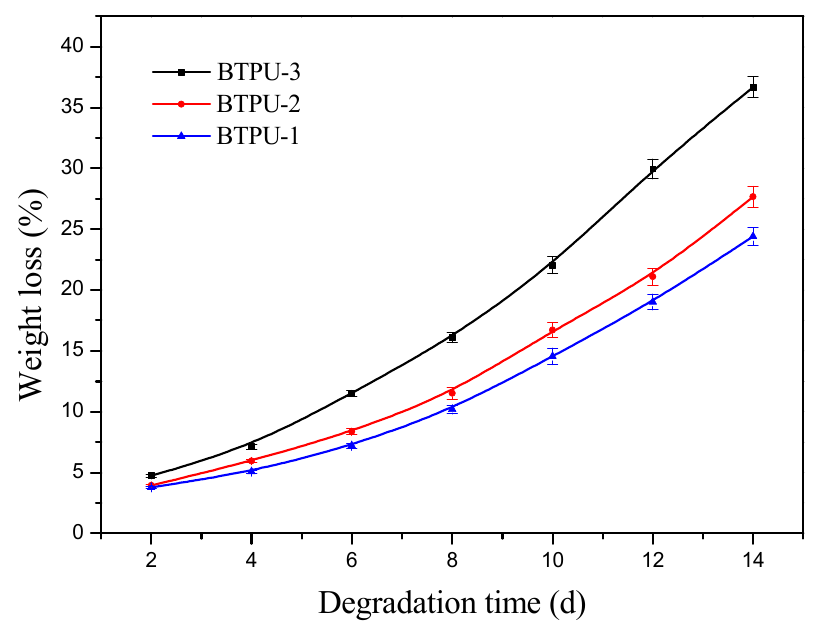
Figure 8. Weight loss of BTPU with different BPD contents after enzymatic degradation.